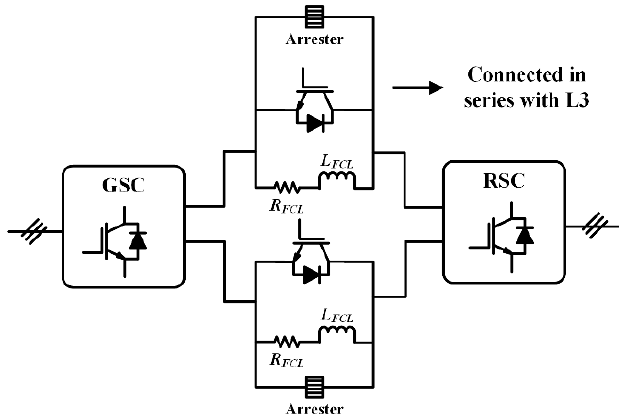
Figure 6. The optimized located FCL [27].